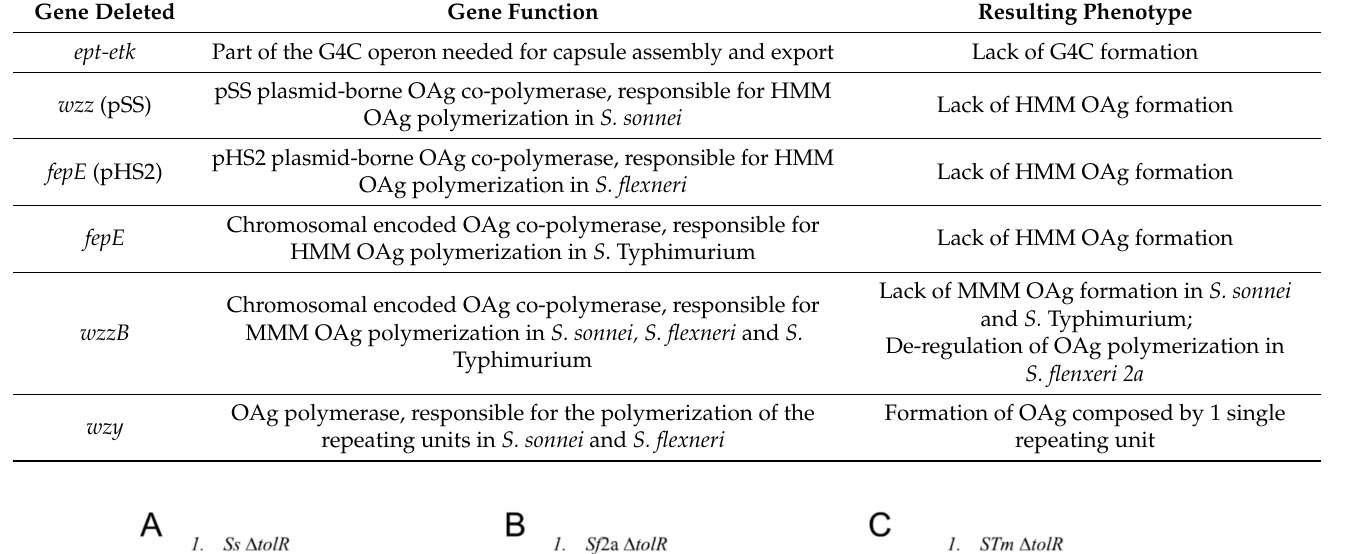
Table 1. Mutations introduced for hypervesiculation and O-antigen (OAg) length regulation.